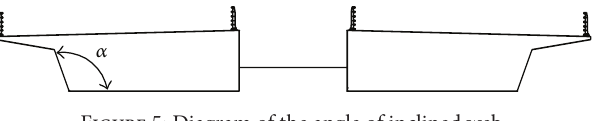
Figure 5: Diagram of the angle of inclined web.